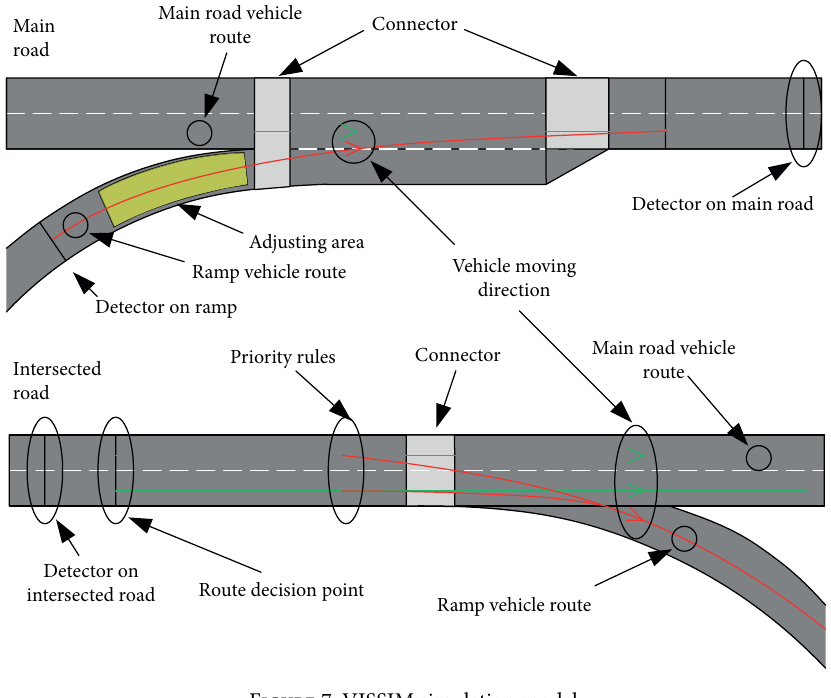
Figure 7: VISSIM simulation model. Table 2: Background traffic input on main road and the merging traffic